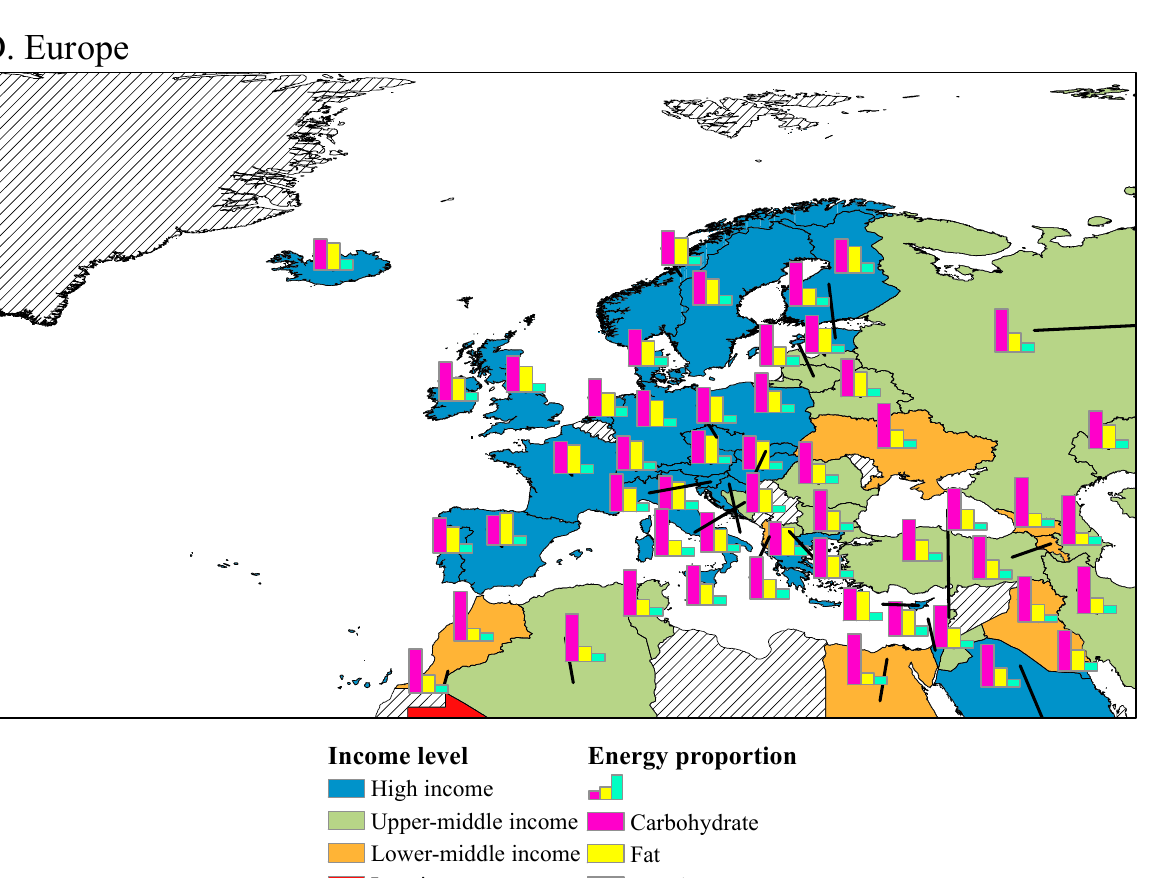
Figure 4. Energy proportion of carbohydrates, protein, and fat for each country (%).